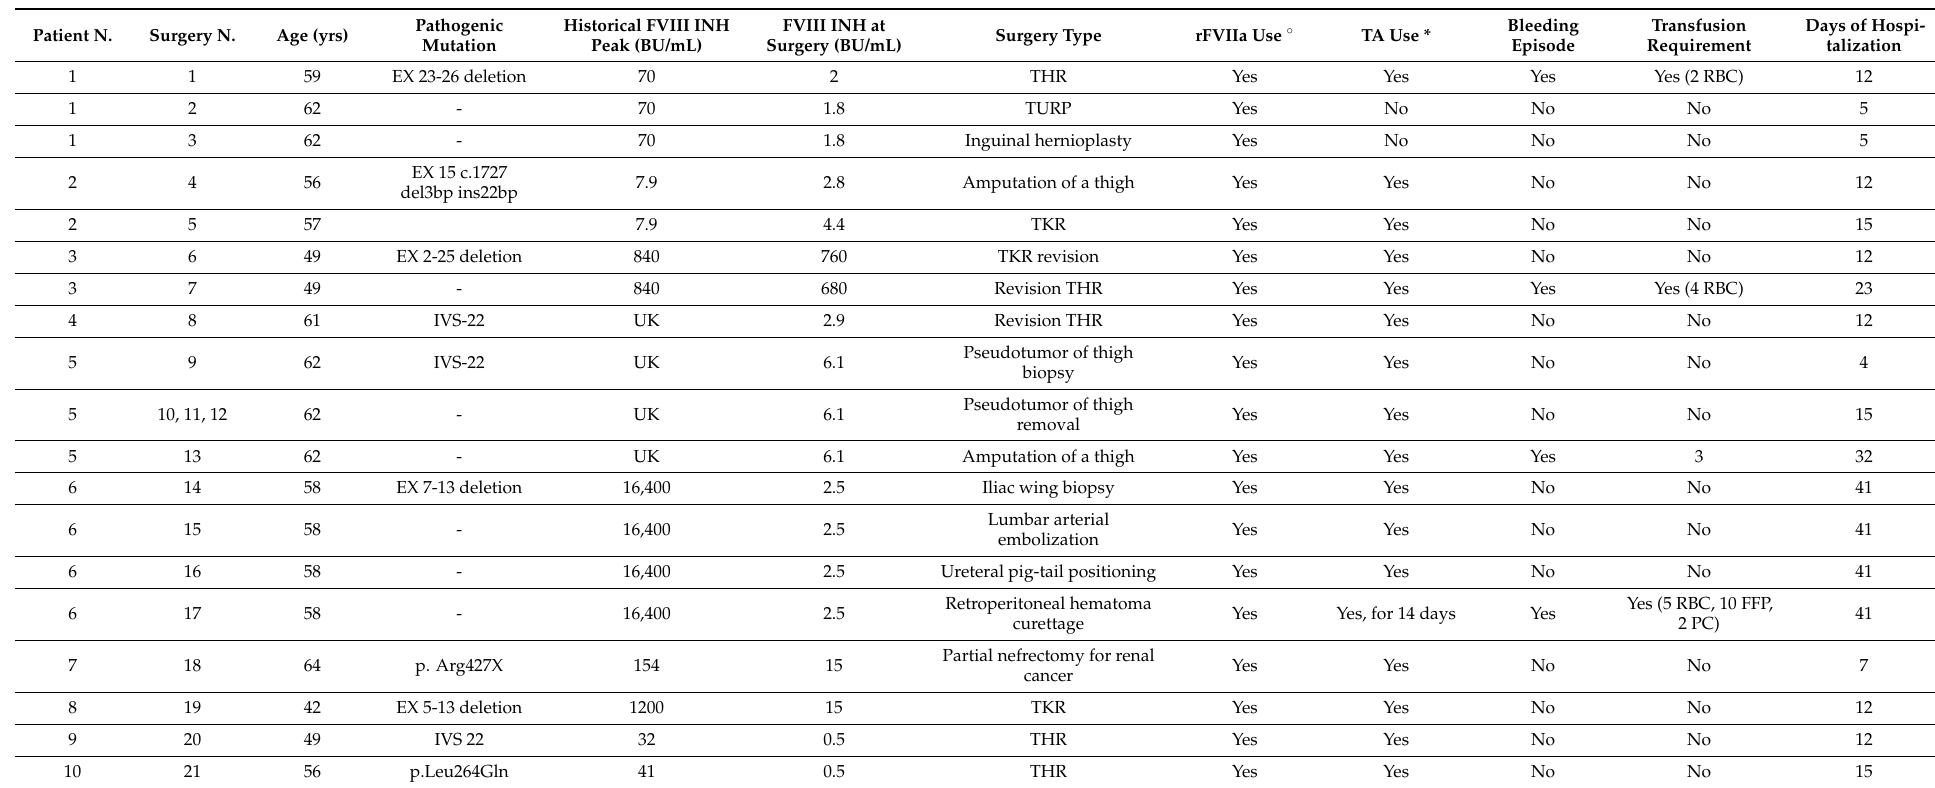
Table 1. Major surgeries in patients with